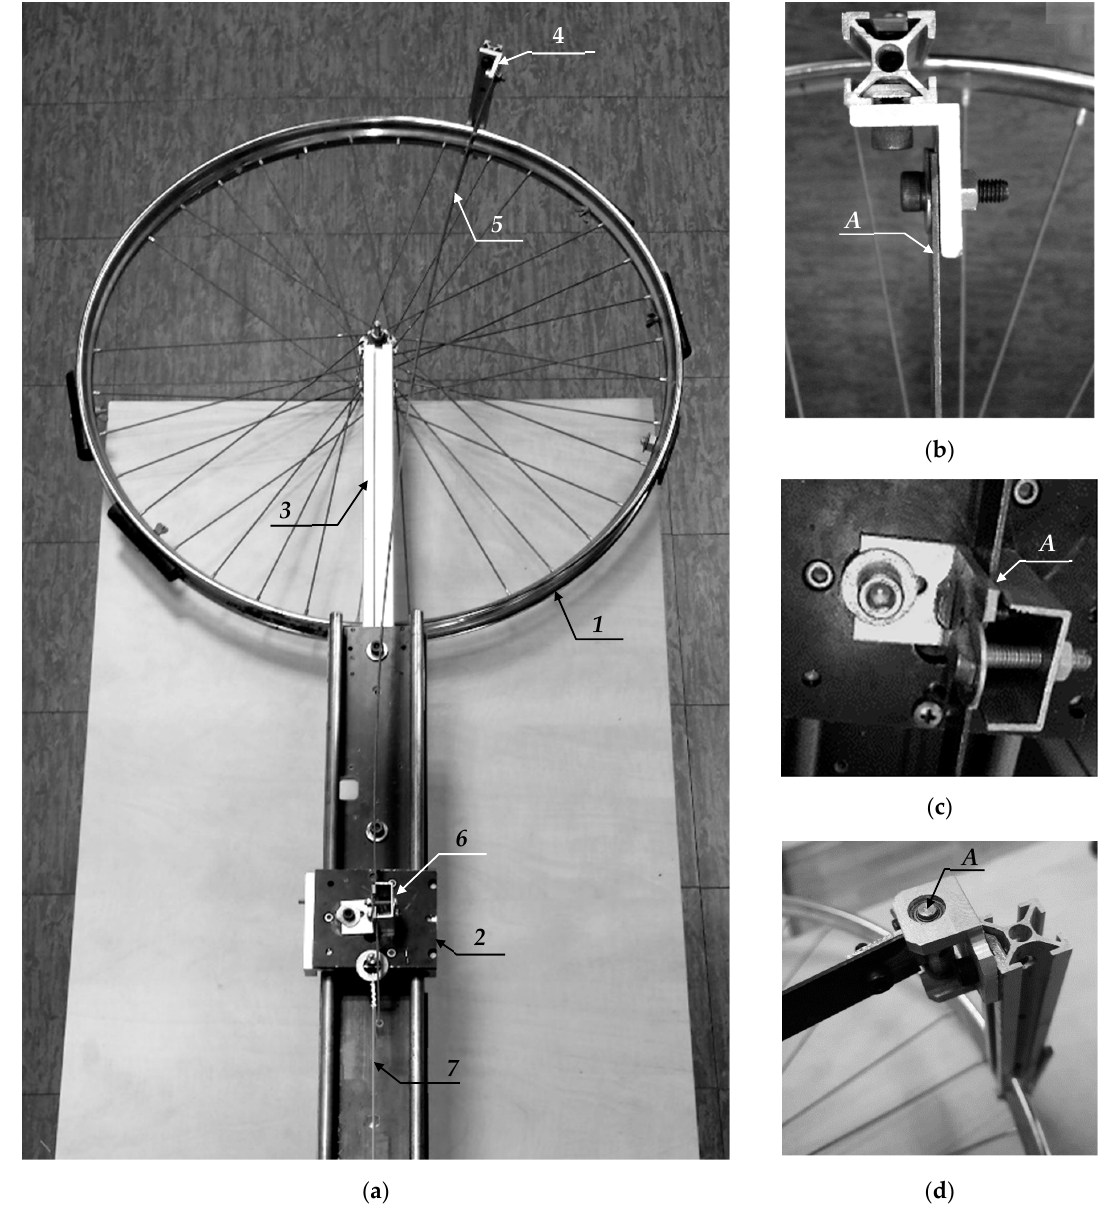
Figure 7. ( a ) Upper view on the horizontal stand for testing systems, including a tensile rod with an end moving along a circular trajectory: 1—wheel, 2—direction slide, 3—basic rod, 4—connection joint to the wheel, 5—elastic rod, 6—connection joint to the direction slide, 7—traction cable; ( b ) rigid joint connection of the elastic rod to the wheel; ( c ) connection joint between elastic rod and direction slide with a screw stopper that allows a rigid or a pinned connection; ( d ) pinned connection of the elastic rod to the wheel.